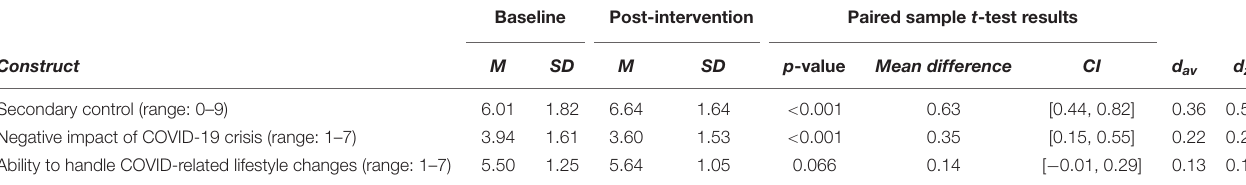
TABLE 3 | Changes from pre-intervention to post-intervention in secondary control and COVID-related questions. Baseline Post-intervention Paired sample t -test